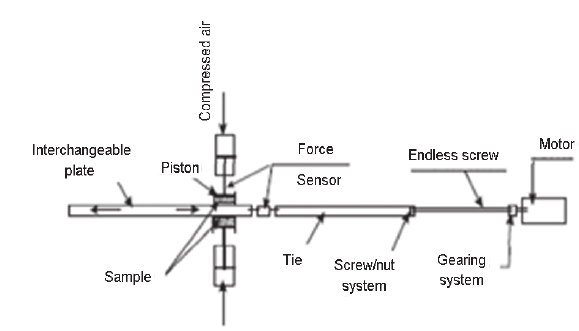
Fig. 3. Friction device (Vanhove 2001)